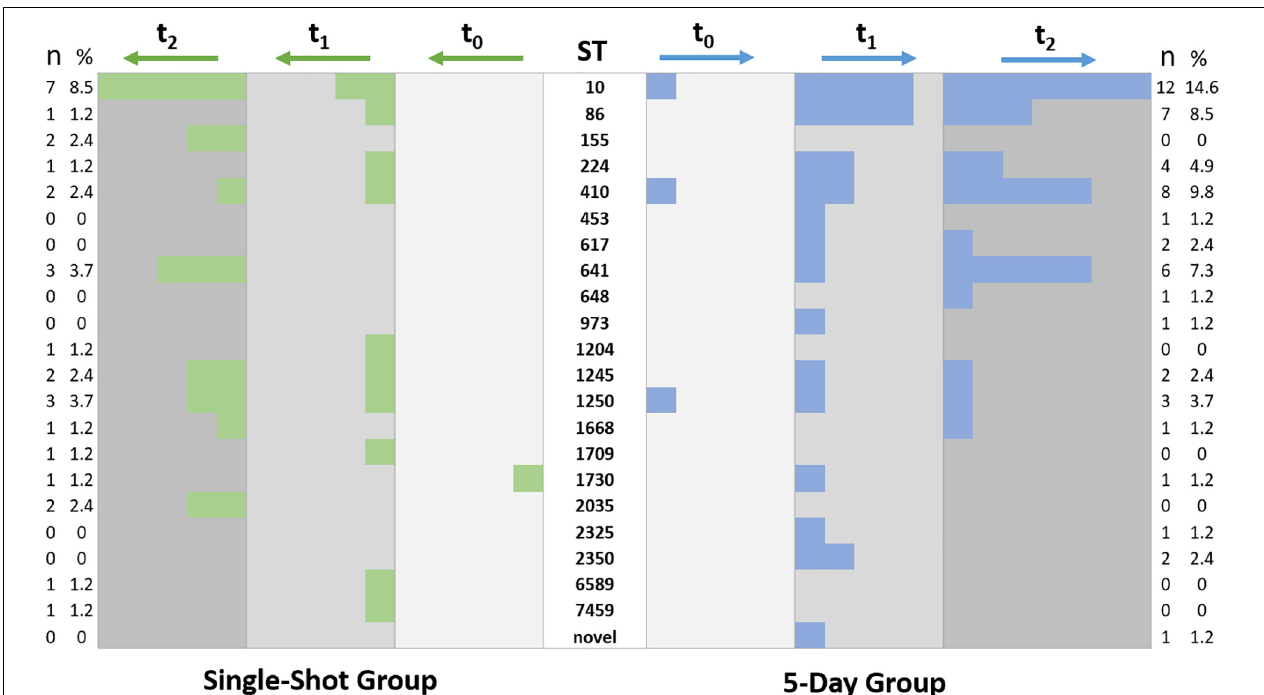
FIGURE 4 | Occurrence and distribution of sequence types associated with equine ESBL-EC. Each colored square indicates an ESBL-EC, isolates of the SSG are represented in green and those from samples of the 5DG are blue. Sampling time points are indicated by different shades of gray and column